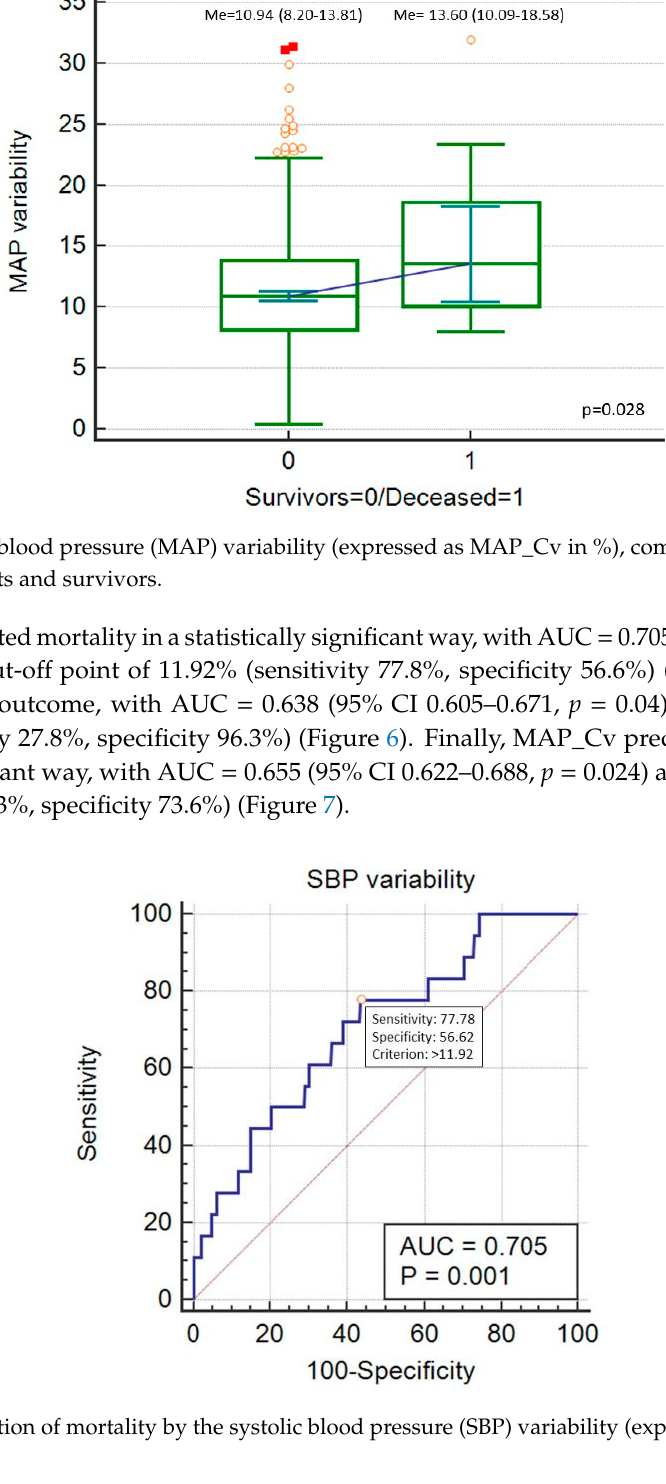
Figure 3. Diastolic blood pressure (DBP) variability (expressed as DBP_Cv in %), comparison between deceased patients and survivors.